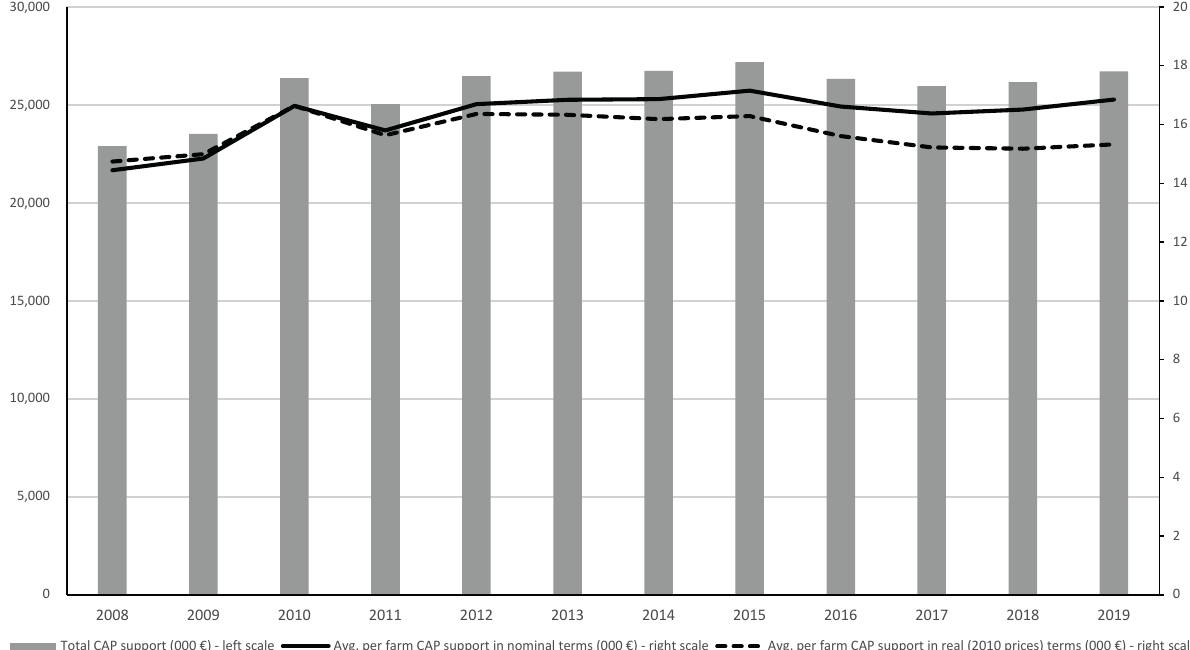
Figure 1. Total and per farm public support within the Italian 2008-2019 FADN balanced